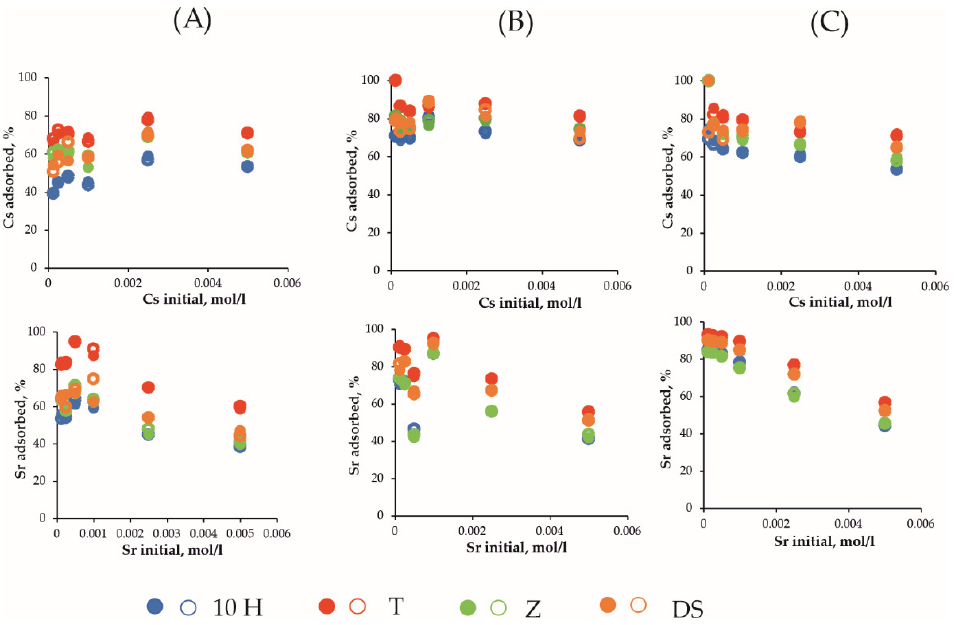
Figure 2. The recovery rate of Cs(I) and Sr(II) from solutions with pH 3 ( A ), 7 ( B ), and 10 ( C ) by bentonites 10H, T, Z, and DS. Empty and filled icons are replications of the experiment.